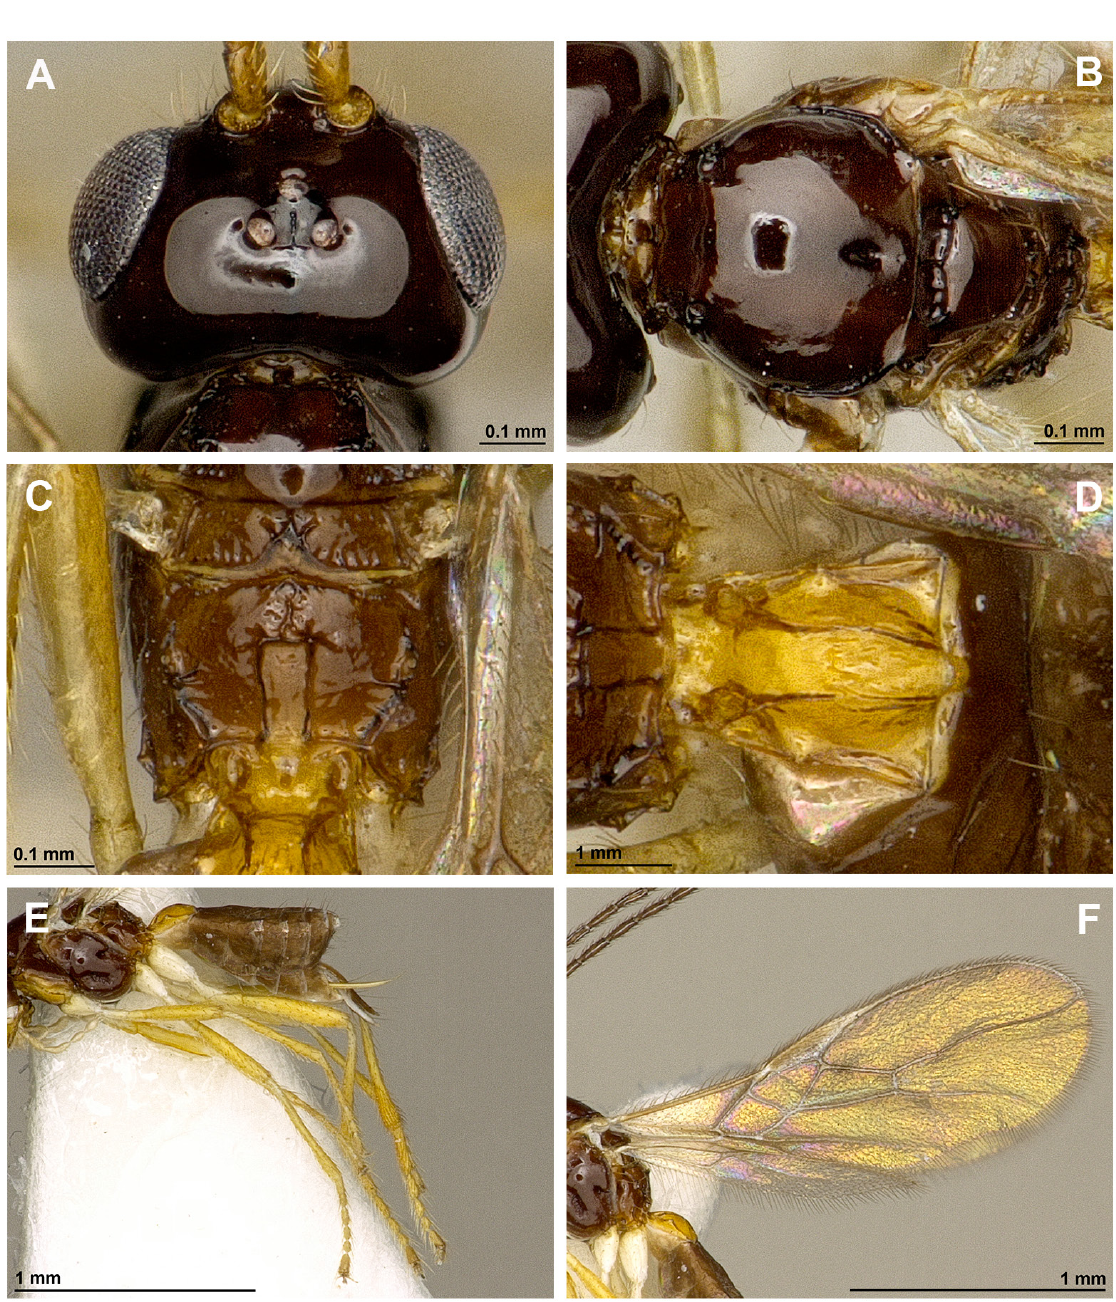
Fig. 40. Asobara mediana van Achterberg, sp. nov., ♀, holotype (RMNH). A . Head, dorsal view. B . Mesoscutum, dorsal view. C . Propodeum. D . First metasomal tergite, dorsal view. E . Hind leg, metasoma and ovipositor, lateral view. F . Fore